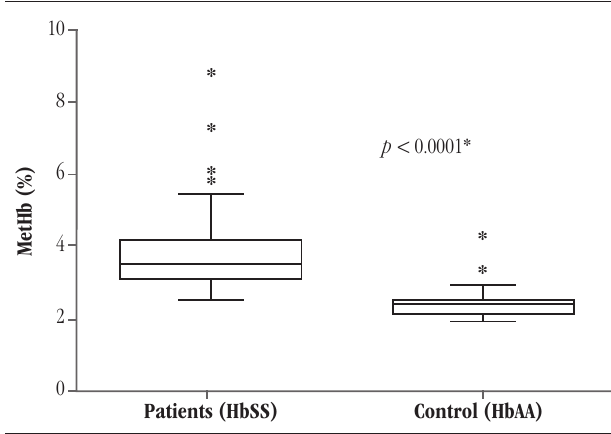
figurE 1 – Comparison of MetHb levels between SCA patients and control group *Significant at the 0.05 level. p value obtained by Mann Whitney test. Results presented as median. figurE 3 – Correlation between MetHb levels and HbF concentration in patients with SCA Spearman correlation test